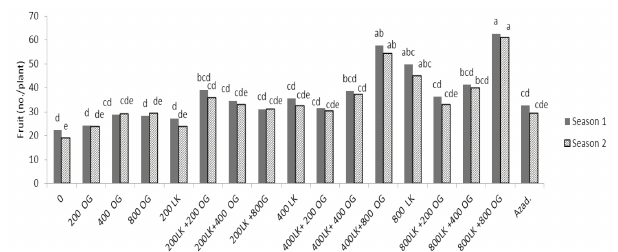
Fig. 6 ­ Effect of fresh plant biomass from the plant species Lippia kituensis and Ocimum gratissimum. on tomato plant fruit per plant. Means followed by the same letter in a letter series within a column per season are not significantly different according to Tukey’s honestly signi­ ficant difference (THSD) at P ≤ 0.05. OG = Ocimum gratis‐ simum L. and LK = Lippia kituensis Vatke, are Soil organic amendments in g/10 Kg soil, 0 = no amendment and AZAD = positive.